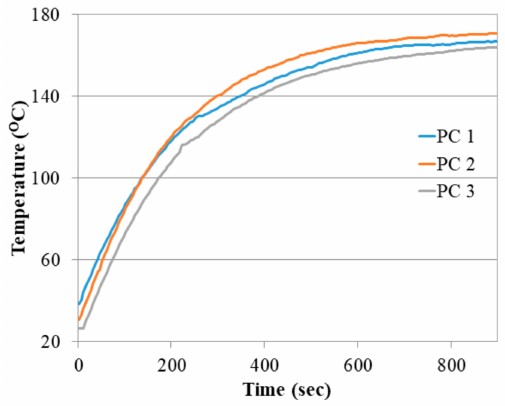
Figure 4. Temperature as a function of time for three different preconcentrator chips applied with a maximum consuming power of 18 W and a voltage of 50 V.